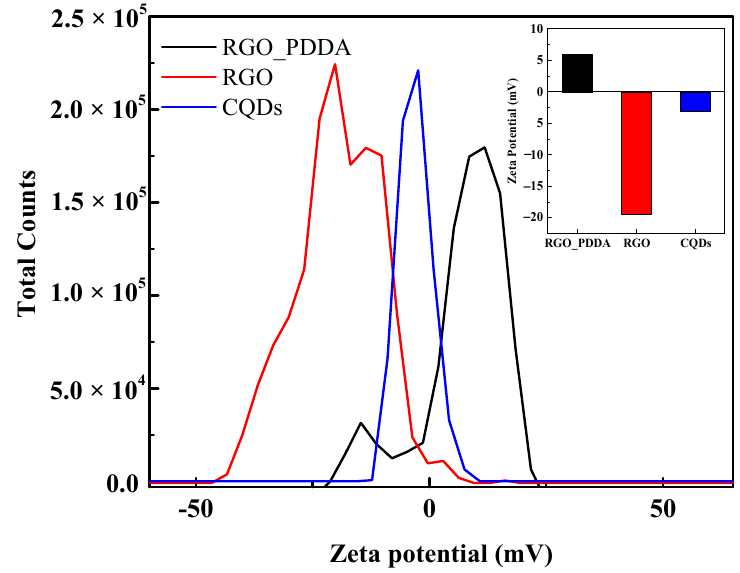
Figure 3. Zeta potentials of RGO, RGO_PDDA, and CQDs.